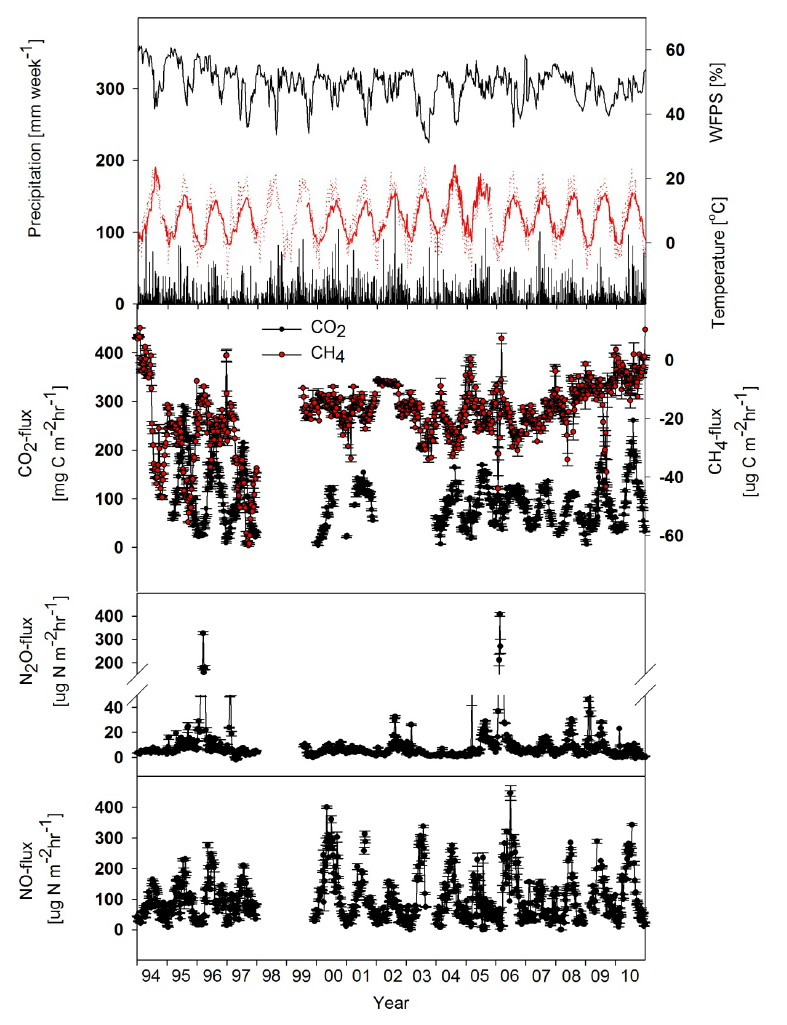
Fig. 2. Weekly averaged values of environmental parameters (upper panel: precipitation (black bars), temperature (red line: soil temperature, red dashed line: air temperature), soil moisture (black line) and trace gas fluxes (second panel to lowest panel: CO 2 , CH 4 , NO, N 2 O) at the H¨oglwald Forest spruce site for the years 1994 to 2010. Error bars for fluxes are representing the standard error of the mean of hourly